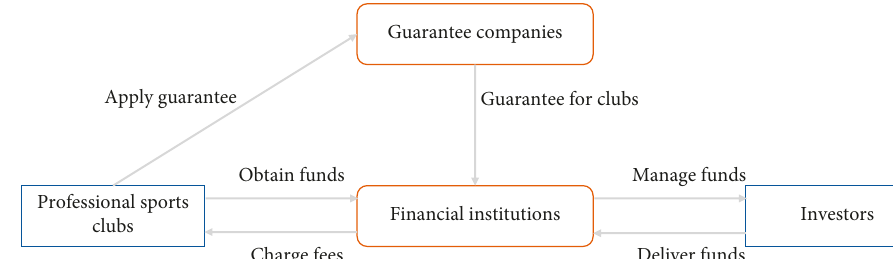
Figure 5: Guaranteed financing process for professional sports clubs.